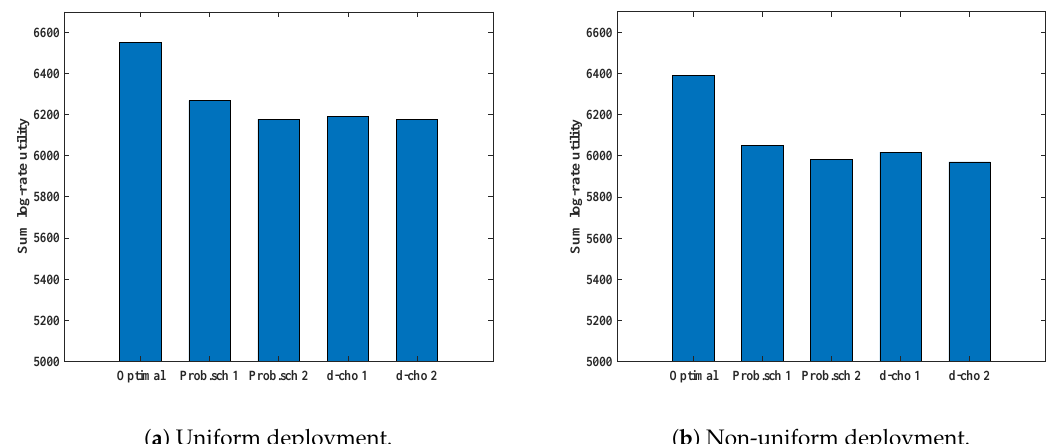
Figure 12. Performance of different association schemes in different deployment scenarios against optimal